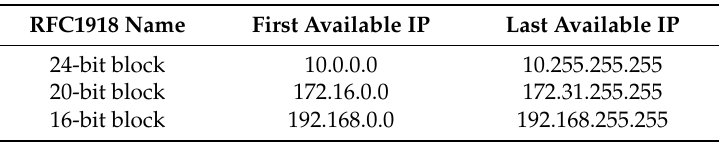
Table 7. Ranges of private IP